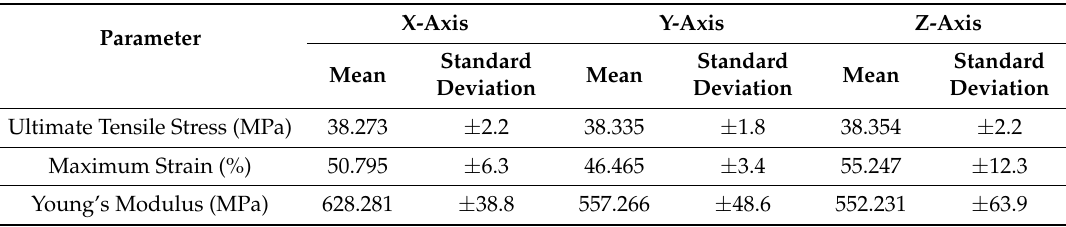
Figure 28. VeroWhitePlus, DM8510 stress–strain curve for the Z-axis (6 specimens). As observed, the red curve (#2) was likely an outlier as the curve deviated too much from the rest. After removing it, Table 4 shows the averages obtained from the remaining five curves. Table 4. VeroWhitePlus, DM8510 combination thermal-mechanical properties.